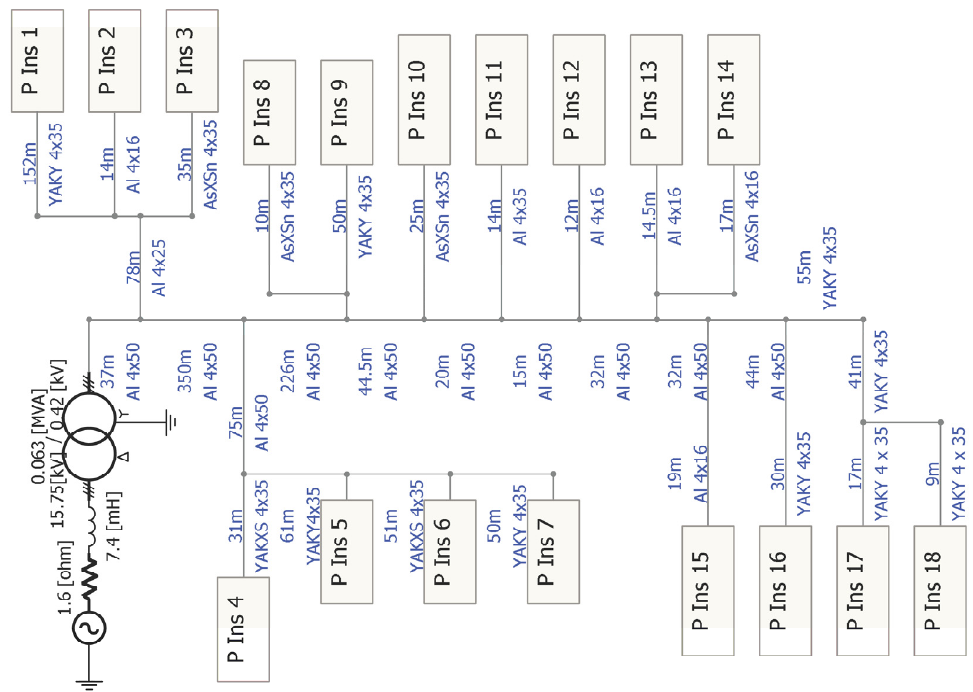
Figure 2. LV distribution network under consideration modelled in PSCAD/EMTDC environment. Prosumer installations (P Ins) were numbered from 1 to 18.